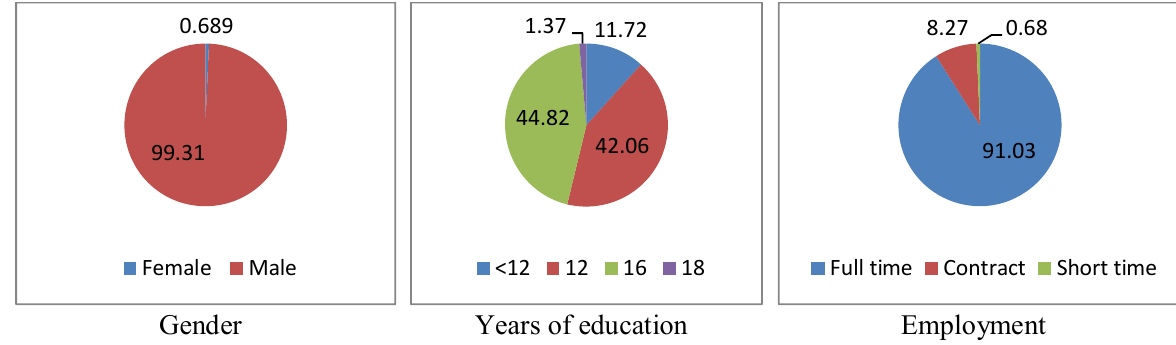
Fig. 1. Personal charactersitics of the